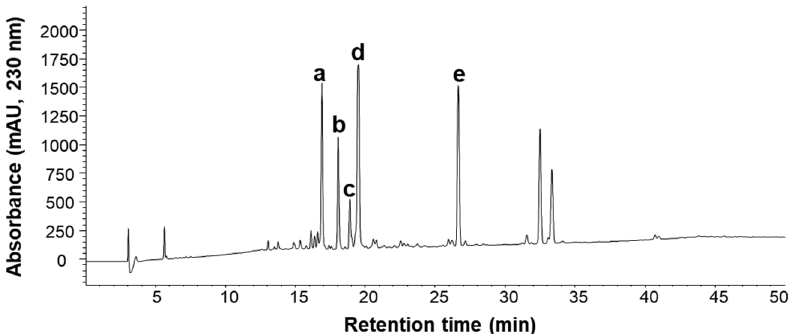
Figure 1. HPLC chromatogram of n -hexane extract of L. strychnifolia.